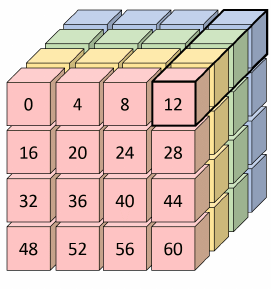
Figure 2: Cubic representation of the main state of GIFT-64 . Each color refer to a slice matrix while the black cuboid is where an Sbox is